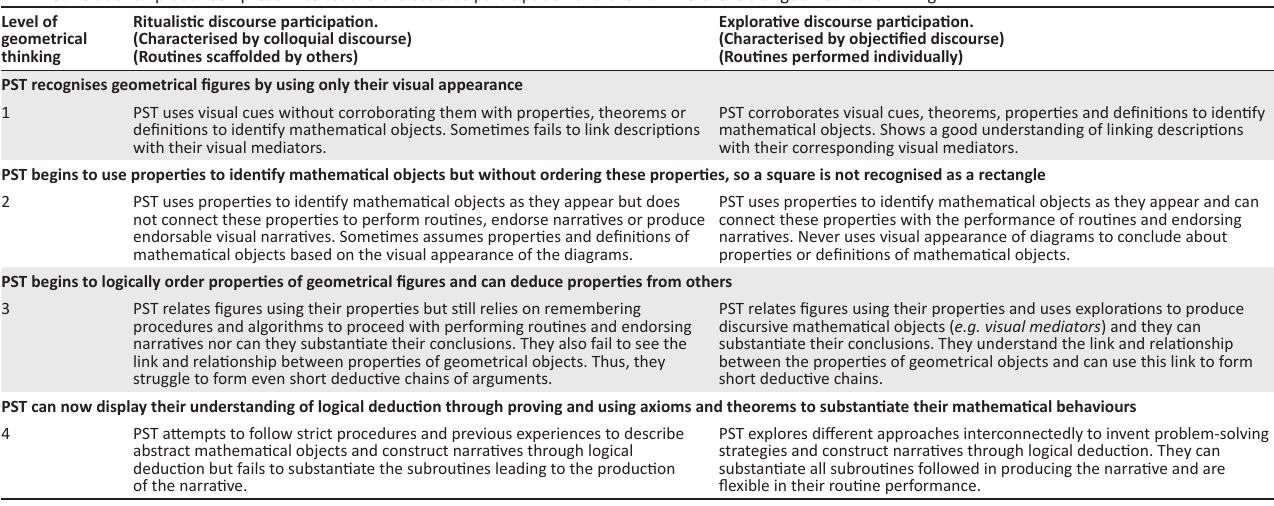
TABLE 3: Relationship between preservice teachers’ discourse participation and the Van Hiele levels of geometrical thinking. Level of